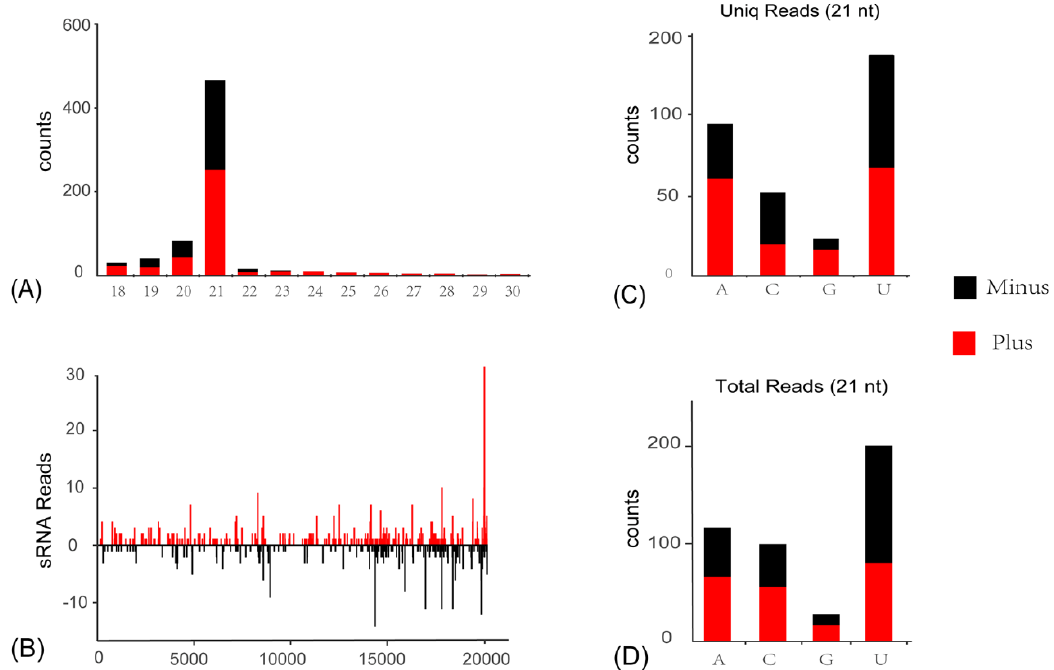
Figure 5. Profiles of virus-derived small interfering RNAs (vsiRNAs) of Cicadella viridis nido-like virus 1 (CvNiLV1). ( A ) Size distribution of CvNiLV1-derived siRNA. ( B ) Distribution of CvNiLV1-derived siRNA along the viral genome. ( C , D ) 5 ′ -terminal nucleotide preference of 21-nt long vsiRNAs analyzed by uniq reads ( C ), and total reads ( D ).